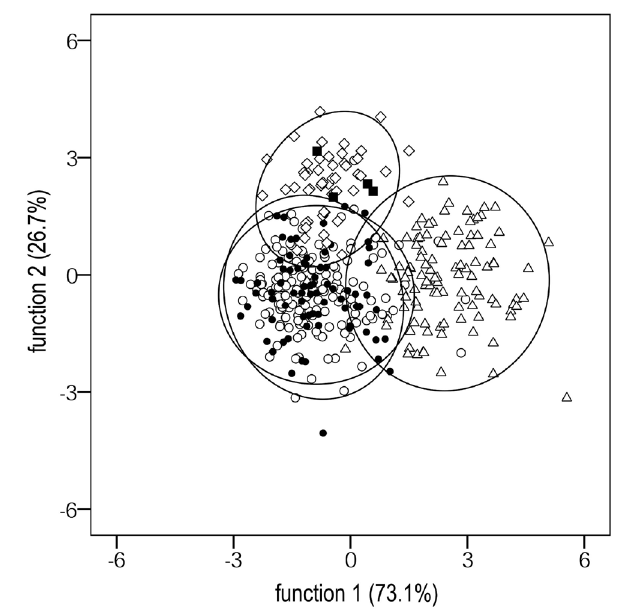
Fig 5. Scatter plot of the discriminant scores of individual workers of Cardiocondyla sl. kagutsuchi in Japan using the first and second functions: lineage A (open circle, n = 165 workers), lineage B (filled circle, n = 75 workers), lineage C (diamond, n = 50 workers), lineage D (triangle, n = 105 workers) and paratypes (filled square, n = 4 workers). Ellipses are 95% confidence limit lines.